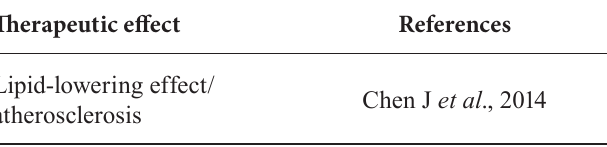
TABLE II - Preliminary studies on pharmacological activity of synthetic berberine